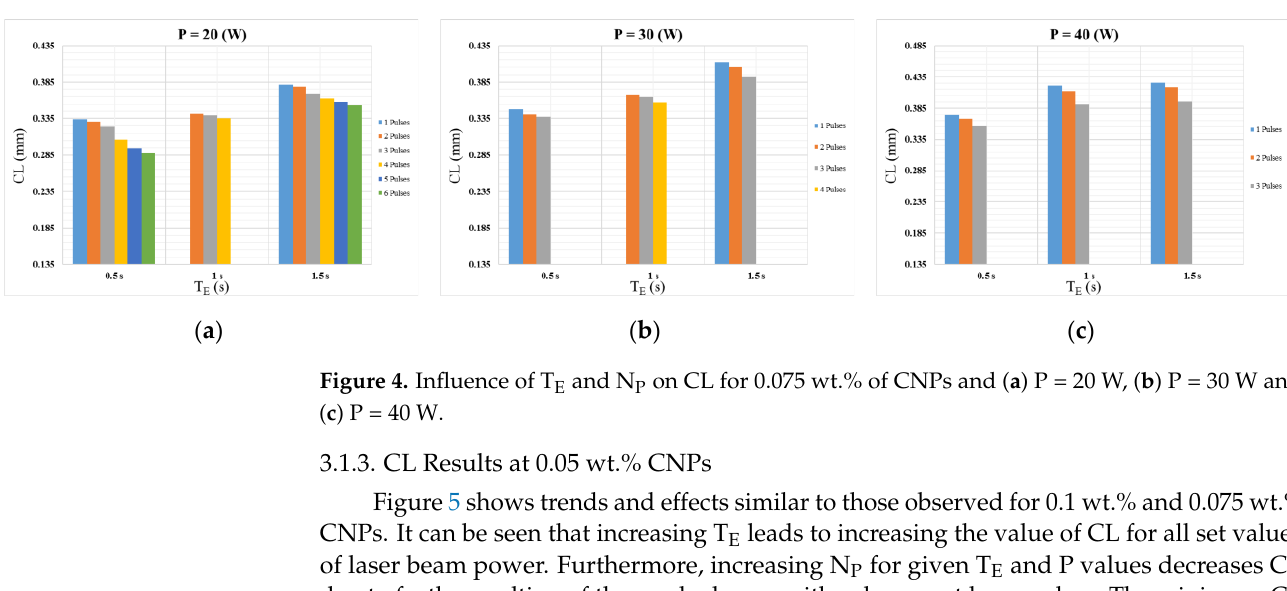
Figure 4. Influence of T E and N P on CL for 0.075 wt.% of CNPs and ( a ) P = 20 W, ( b ) P = 30 W and ( c ) P = 40 W.